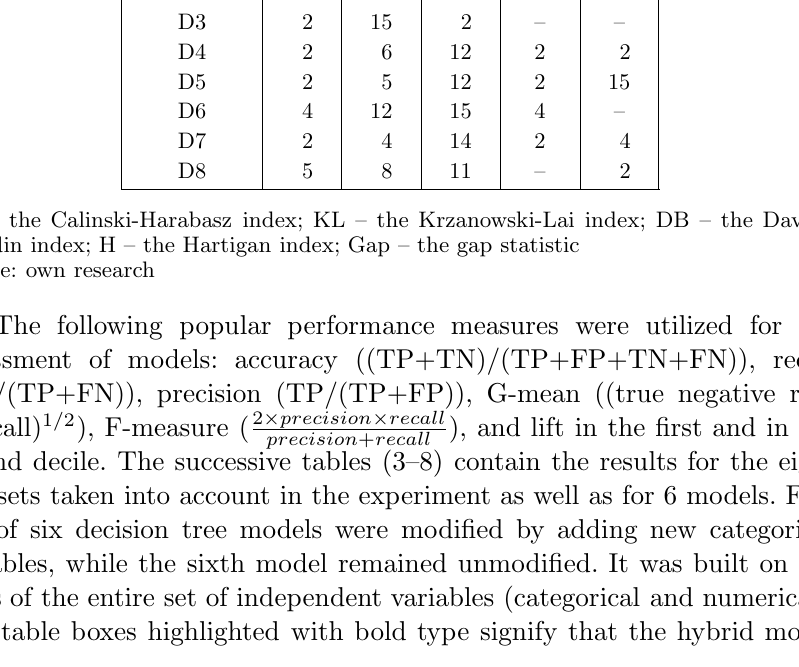
Number of clusters indicated by particular cluster validity measures Cluster validity measures Dataset CH KL DB H Gap